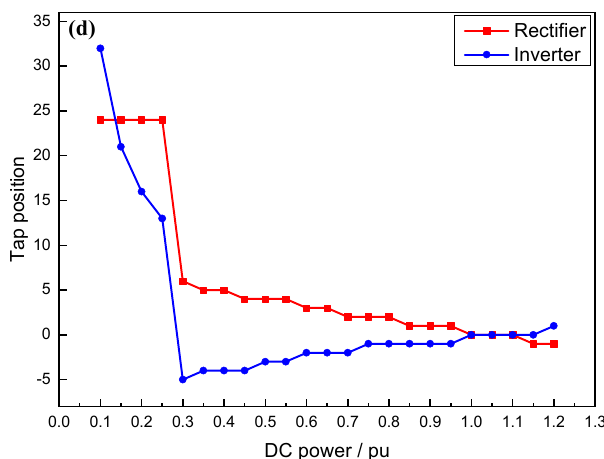
Figure 7. Relationships between some main circuit parameters and the DC power: ( a ) relationship between the angles and the DC power, ( b ) relationship between the DC voltage and the DC power, ( c ) relationship between the reactive power consumption and the DC power, ( d ) relationship between the tap position and the DC power.